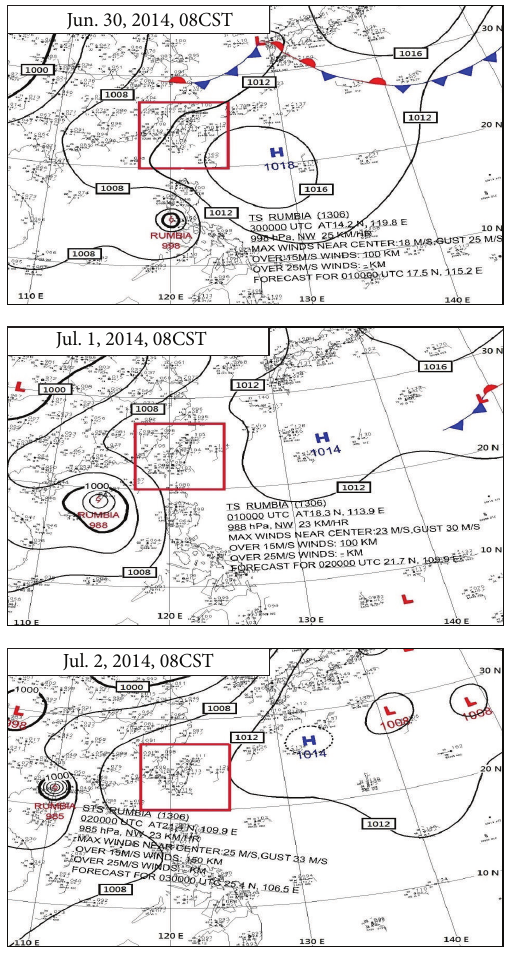
Figure1:SurfaceweatherchartfromJune30toJuly2,2013,reported by Taiwan Central Weather Bureau (CWB).